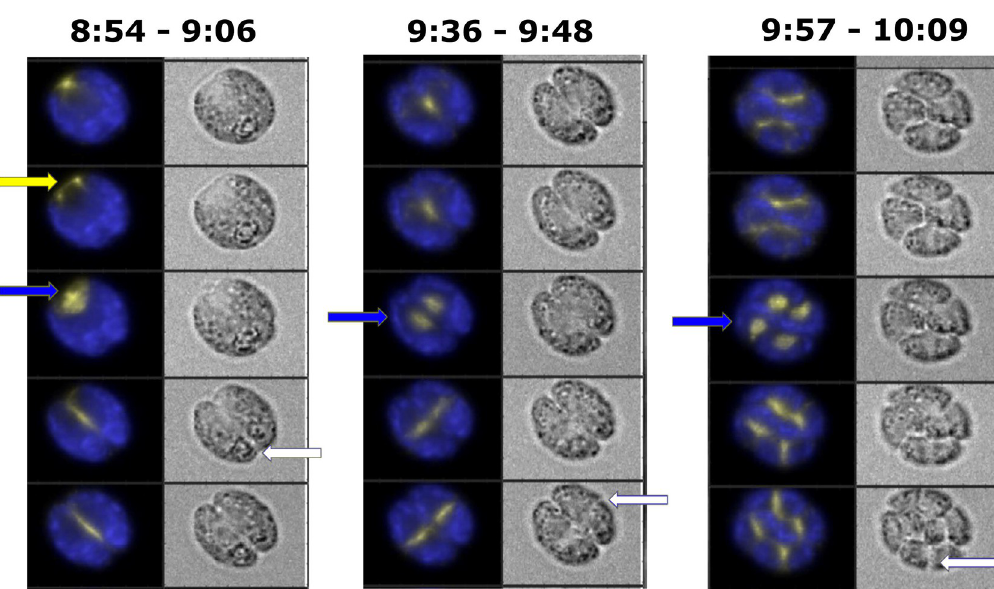
Fig 7. Live cell time-lapse of wild-type EB1 : NG-TG cells with 3-min. intervals. Live cell time-lapse with 3-min. intervals acquired with microscopy method 1 (see Methods section). Each cell has a brightfield image (right), and a composite of EB1-NG signal in yellow and chloroplast autofluorescence signal in blue (left). Yellow arrow: spindle pole separation. Blue arrows: new spindle formation. White arrows: new cleavage furrow formation. Time indicated on top of each strip is hours and minutes after beginning of time-lapse. The indicated time corresponds to the top cell in each strip. Each subsequent cell going down is from an image captured every 3 minutes.